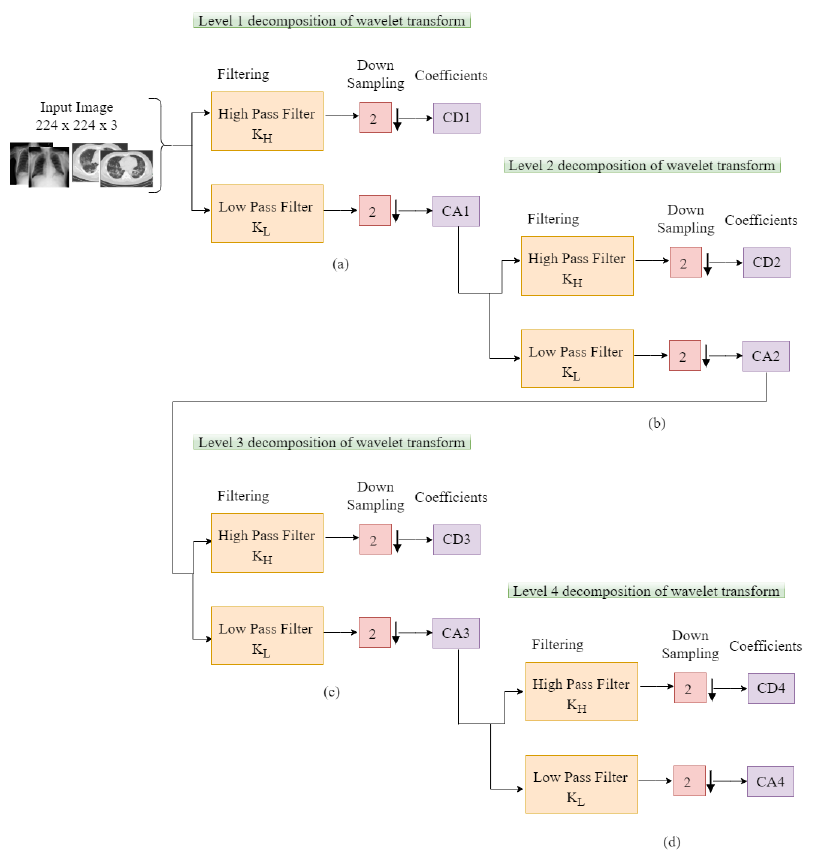
Figure 7. ( a )–( d ) Detailed structure of the wavelet multiresolution analysis of four-level